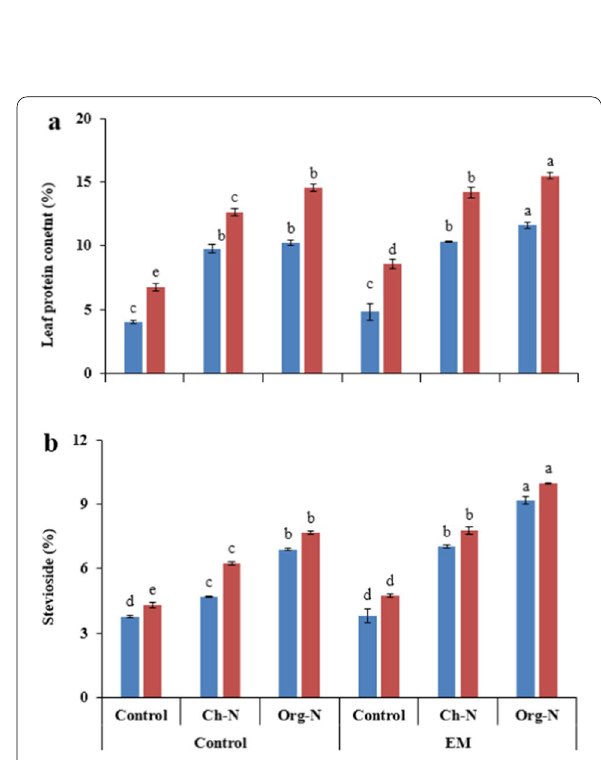
Fig. 4 Effect of different nitrogenous fertilizers and effective microorganisms on leaf protein ( a ) and stevioside ( b ) contents of stevia during two growing seasons (2018–19). Ch - N chemical nitrogenous fertilizer, Org-N organic nitrogenous fertilizer, EM effective microorganisms. Each value expressed in figure is mean of two cuttings. Vertical bars indicate mean standard deviation. ± Means followed by the same letter within the same series are not significantly different according to Fisher’s least significant difference (LSD) technique (p ≤